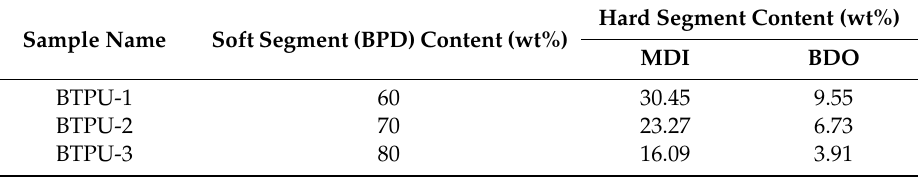
Table 1. Compositions of various biodegradable thermoplastic polyurethanes